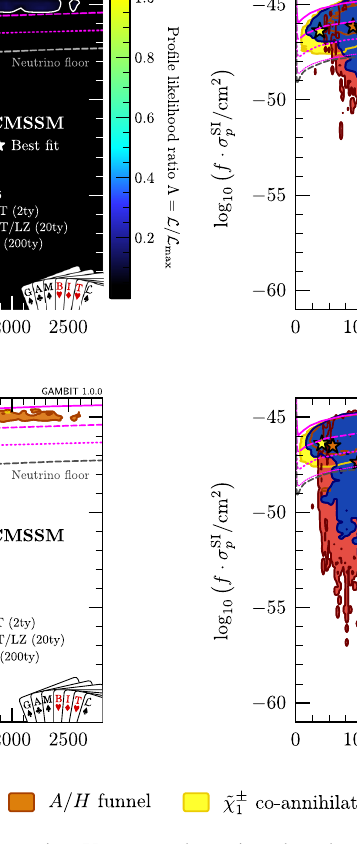
the projected reach of XENON1T with two years of exposure, the pro- jected reach of XENONnT/LZ with 20 tonne-years of exposure [334] (around 1–3 years of data), and the projected reach of DARWIN with 200tonne-yearsofexposure[335](around3–4yearsofdata).The“neu- trino floor”, where the coherent neutrino background starts to limit the experimental sensitivity, is indicated by the dashed grey line [336]. The exact position of this limit is subject to several caveats; see [336] for further